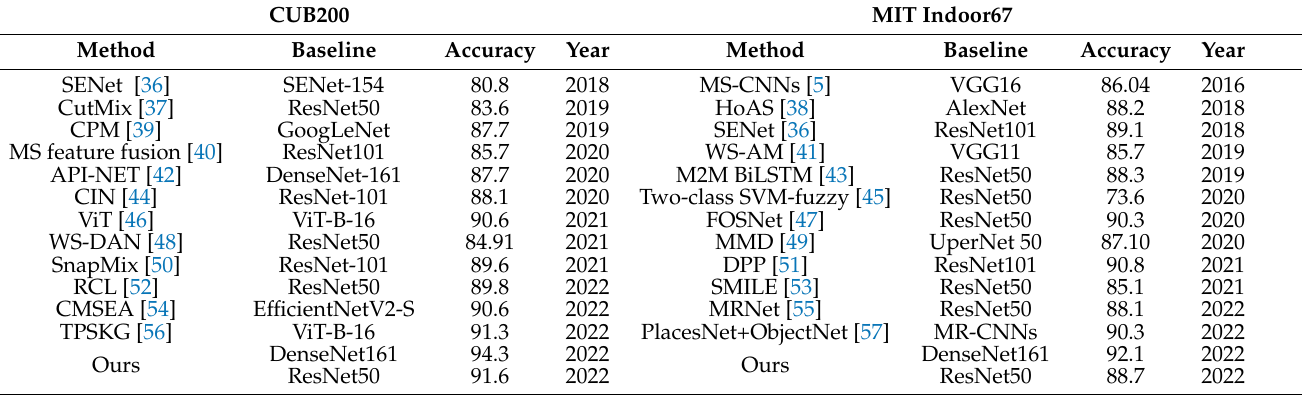
Table 6. Comparisons with state-of-the-art